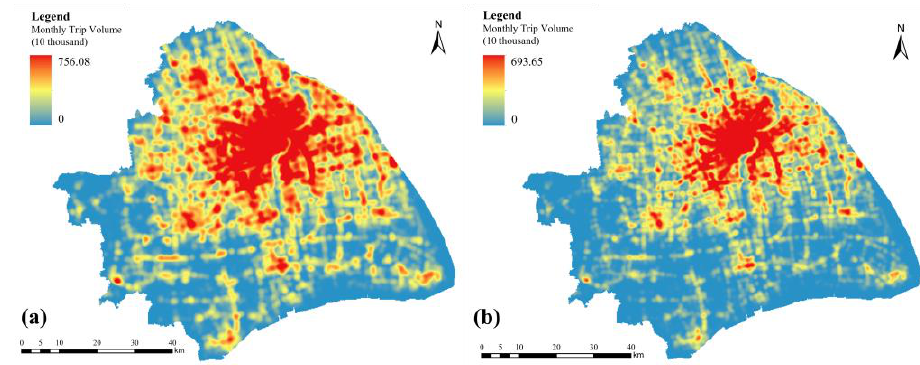
Figure 7. Distribution of travel trajectories for males ( a ) and females ( b ).